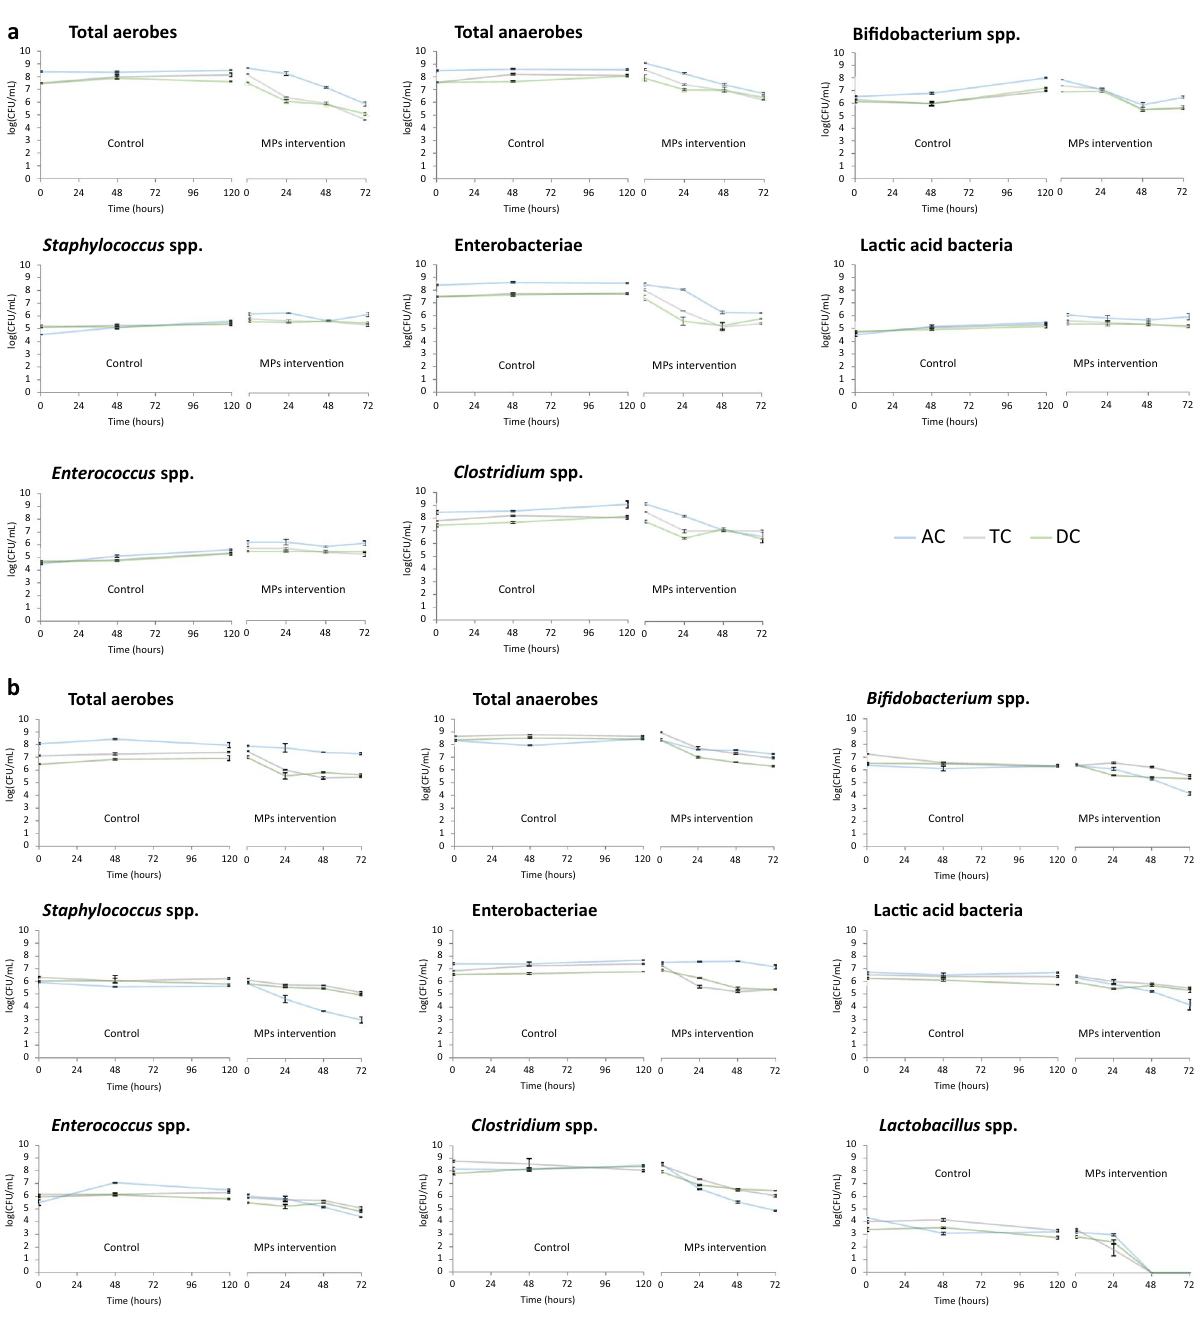
Figure 3. Evolution of the main microbial groups evaluated by plate counting for simgi colonic compartments during control period (0–120 h) and MPs intervention (0–72 h). Figure 3.a show the results for volunteer 1 and Fig. 3.b for volunteer 2. AC ascending colon, TC transverse colon, DC descending colon, CFU Colony formatting